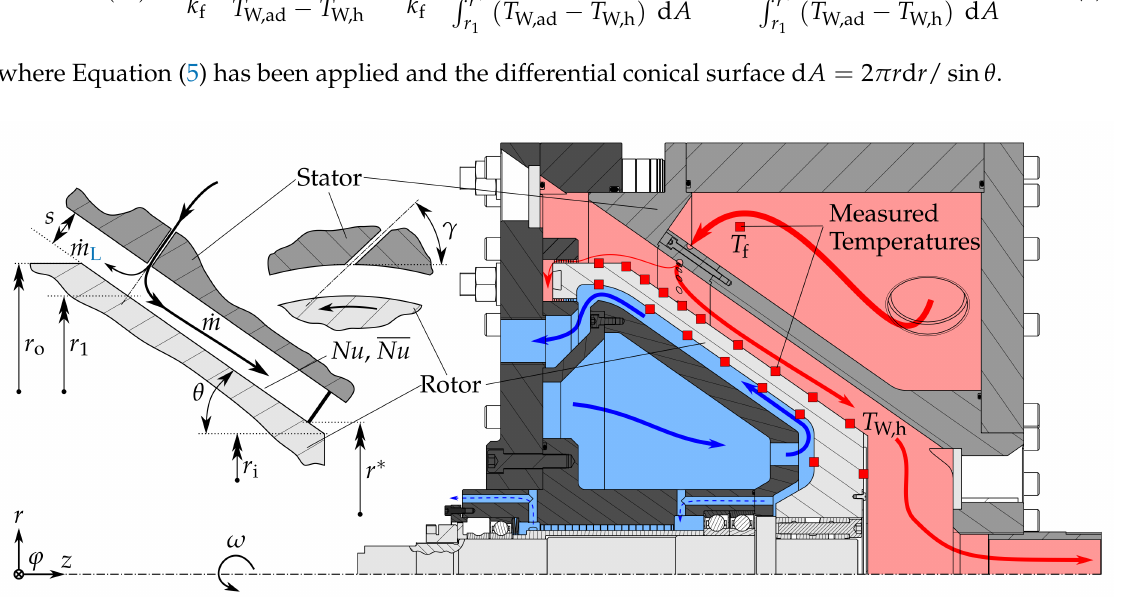
Figure 2. Scheme of the physical problem with variable input parameters and test rig setup with schematic illustration of the temperature measurements ( )